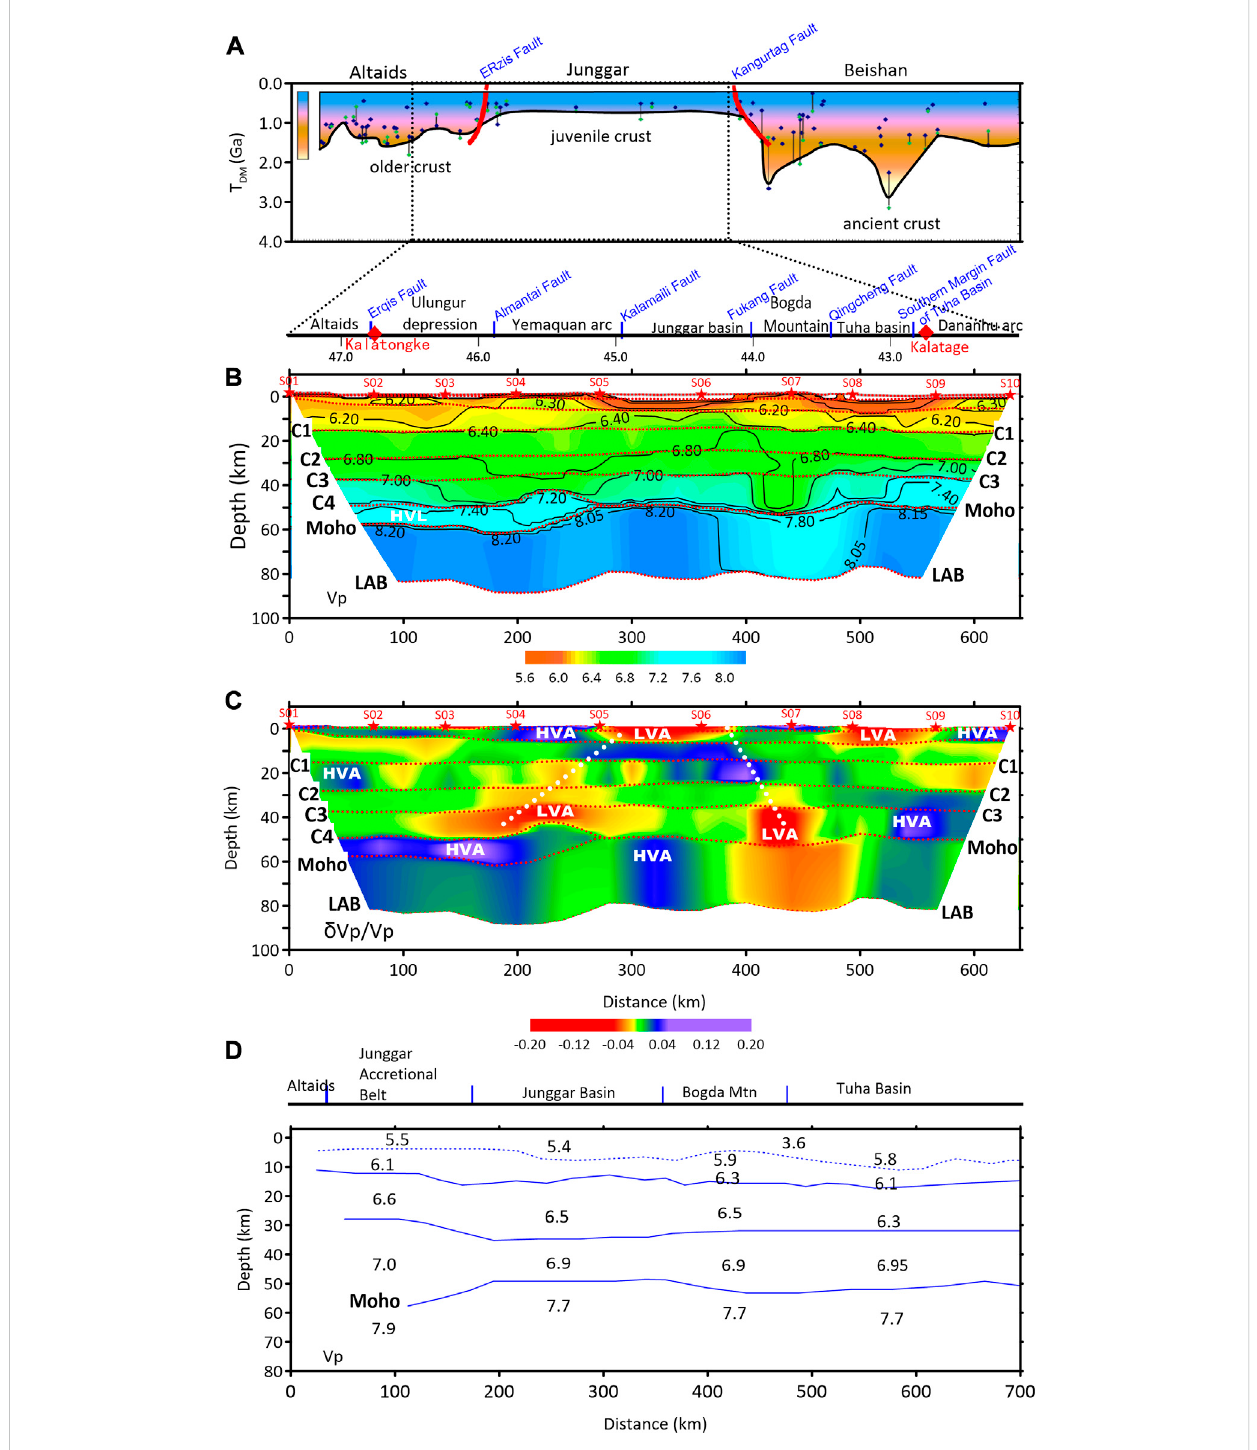
FIGURE 5 Reconstructed P-wave velocity model and comparison with other models. (A) Nd isotopic model age (T DM ) pro fi le along the study region (revised from Wang et al., 2020). (B) Final reconstructed P-wave velocity model (velocity values in km/s). (C) Velocity perturbation percentage of the fi nal model oncesubtractedandthendividedbytheaverageVpvelocityofthesamevelocitylayer.ThewhitedashedlinesdenotepossiblePaleozoicsubduction. (D) For comparison purposes, this plot includes the neighboring crustal P-wave velocity structure provided by Wang et al. (2003). Structures and faults traversedbythepro fi leareindicatedontopoftheplots;reddiamondsmarkthelocationoftheKalatongkeandKalatagemineraldepositstothenorthand south of the pro fi le,